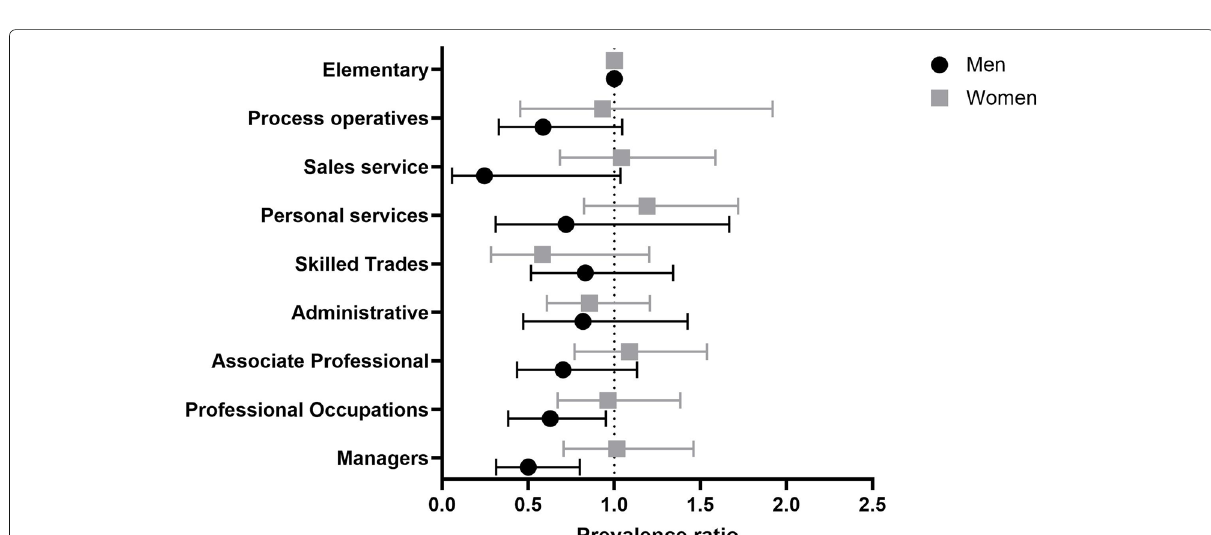
Fig. 3 Forest plot illustrating the prevalence of migraine among occupational categories. Means with error bars plot of the data from Table 3. The point estimate is the prevalence ratio (fully adjusted model) of migraineurs compared with controls in the different occupational sectors as defined by